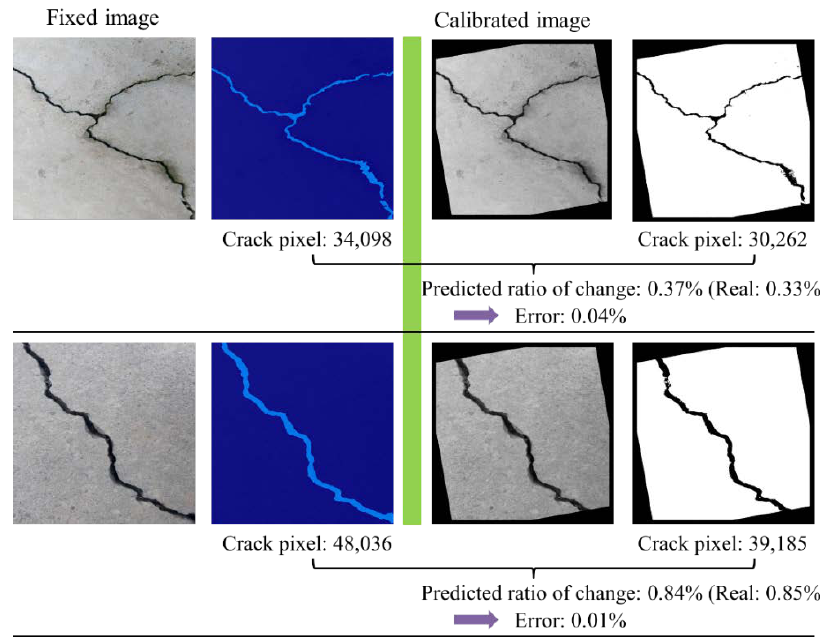
Figure 12. The change ratio of crack pixels.